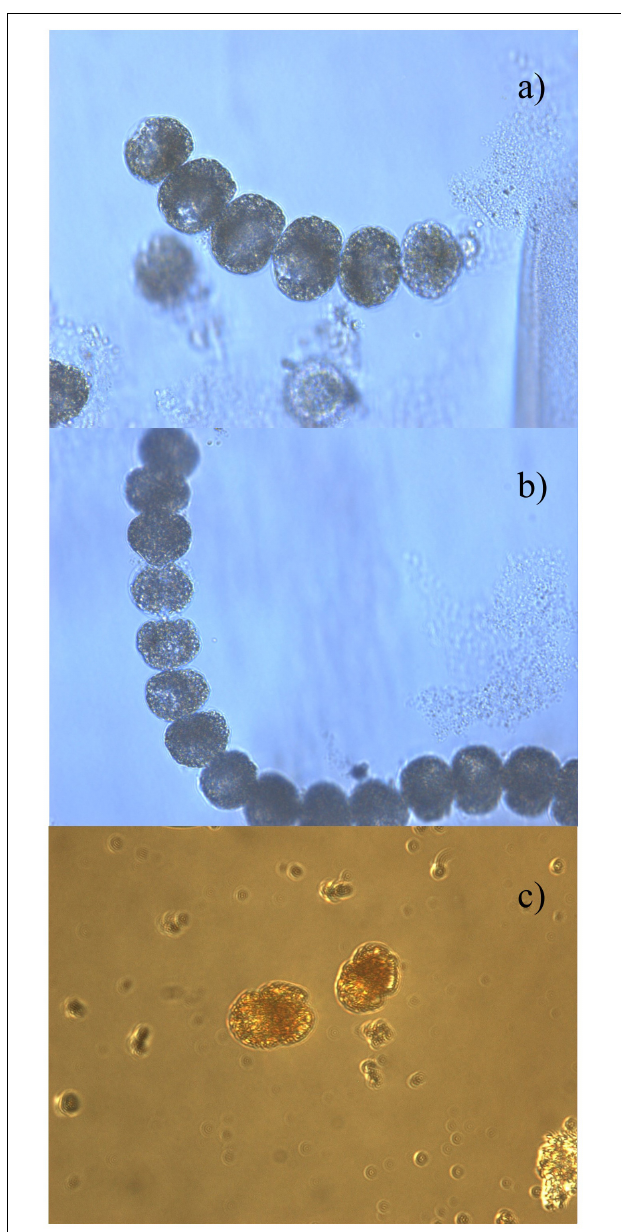
FIGURE 6 | Microphotographs of Lugol-preserved colonies associated with toxic or non-toxic species collected on the Ecuadorian coast: (A,B) Gymnodinium catenatum (Graham, 1943) found in San Pedro (Zone 1) in 2018. This taxon is associated with a paralytic toxin; (C) Cochlodinium catenatum (Schütt, 1896), found in La Libertad in Zone 1 in March